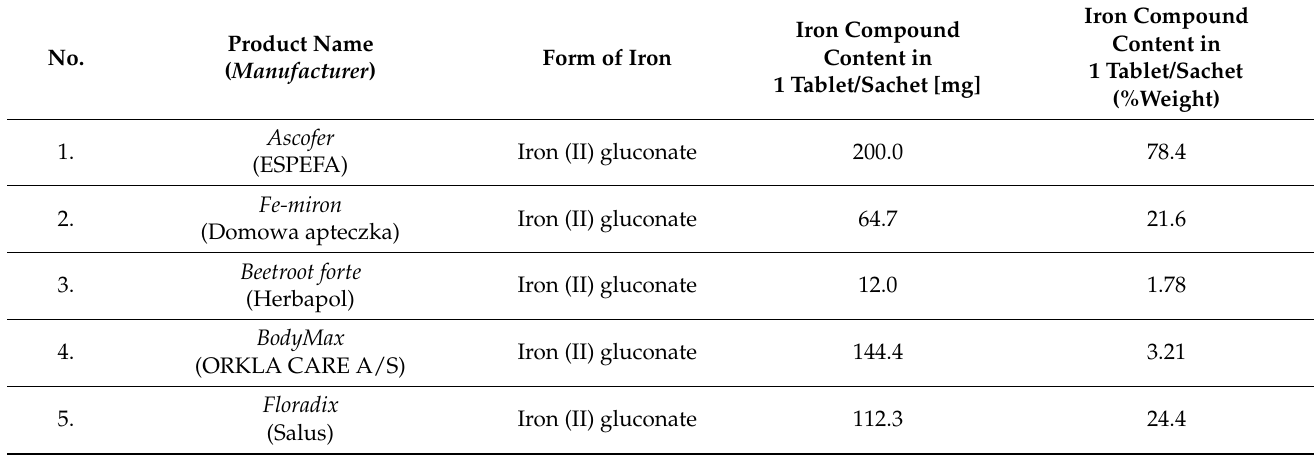
Table 10. Analyzed dietary supplements containing iron compounds.